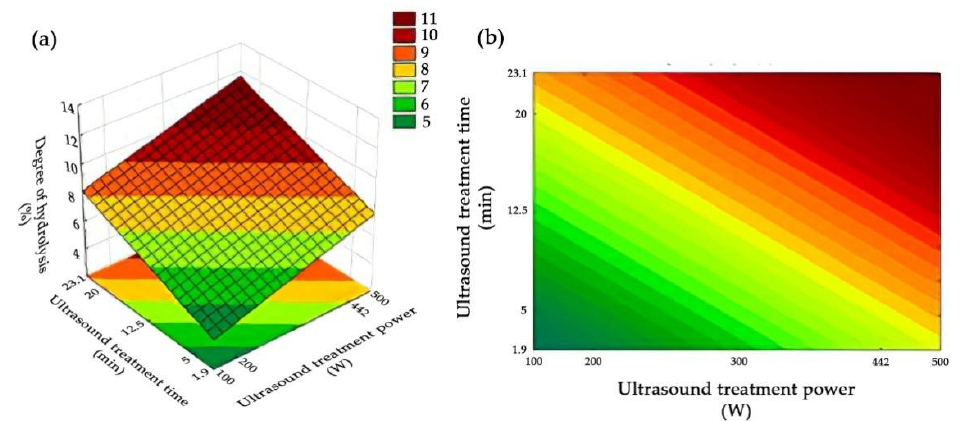
Figure 3. Response surface of sequential hydrolysis composed of ultrasound and enzymatic steps at 8 h. ( a ) Surface plot; ( b ) Counter plot.